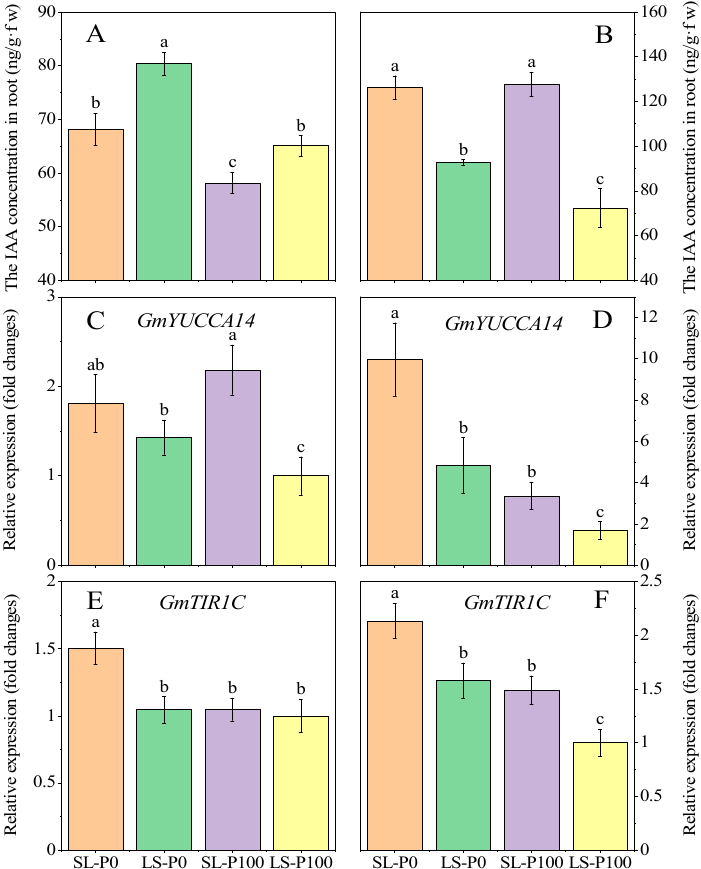
Figure 8. The effect of P application and light condition on the IAA concentration (( A ): V5 stage, ( B ): R3 stage), and the expression of gene GmYUCCA14 (( C ): V5 stage, ( D ): R3 stage), GmTIR1C (( E ): V5 stage, ( F ): R3 stage) in the pot experiment. Plants were grown in two light conditions (SL: shade from sowing to the V5 stage and from V5 to R8 under natural light condition; LS: from sowing to the V5 stage under natural light condition and shade from V5 to R8) and two P application treatments (P0 = without P application; P100 = 100 mg P kg − 1 soil application). Values represent the mean of three replicates ± SE. Different letters on the columns are used to indicate means that differ significantly by LSD ( p ≤ 0.05). For GmYUCCA14 and GmTIR1C expressions, data are expressed as relative values based on the expression of GmYUCCA14 and GmTIR1C in roots of soybean grown under the treatments of SL-P100 and SL-P100 at V5 stage referenced as 1.0, respectively.